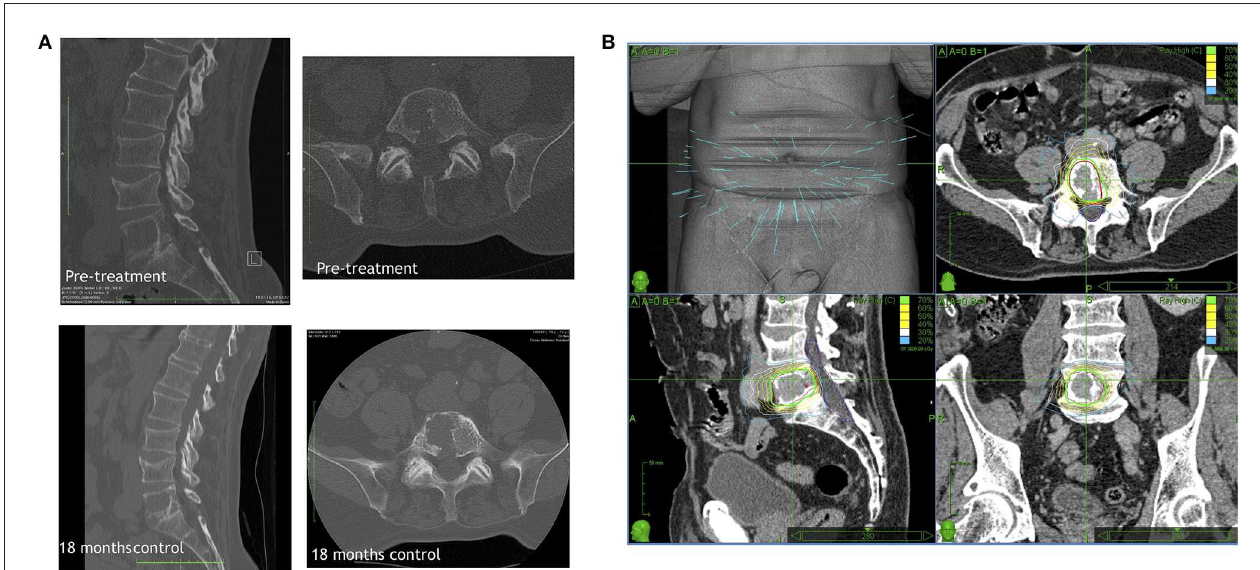
FIGURE 2 | A representative primary Cyberknife treatment case showing (A) the CT scan of the lesion before and 18 months after the treatment visualizing the stable lesion and (B) the Cyberknife therapy planning.